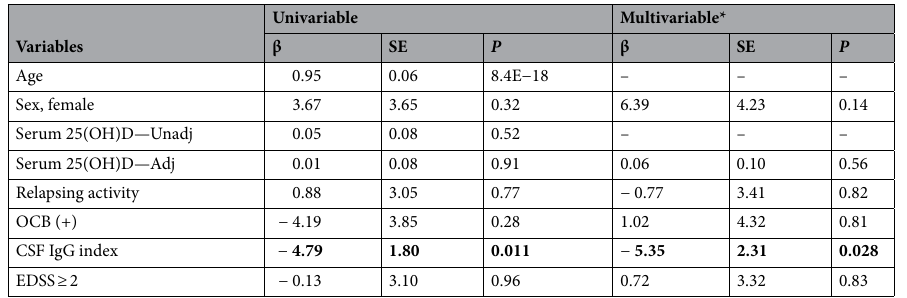
Table 2. Multivariable linear regression of age at MS symptom onset on serum 25(OH)D levels adjusted for season of sampling and disease characteristics. Associations reaching statistical significance ( P < 0.05) are highlighted in bold. * All the variables listed were included in the final